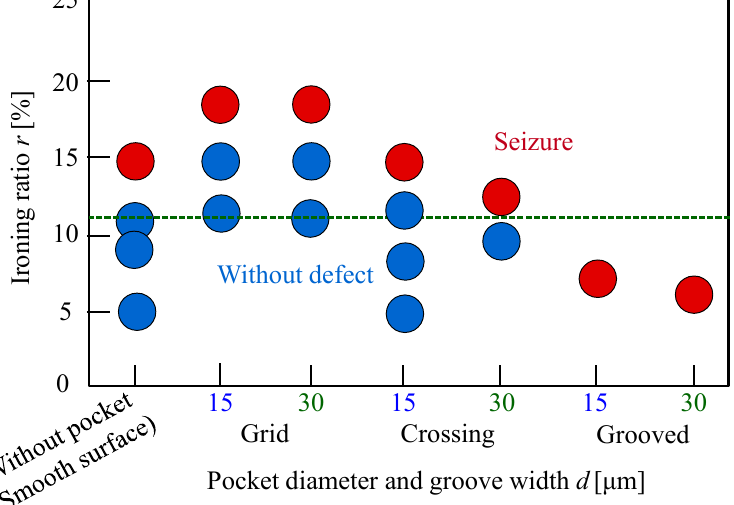
Figure 15. Ironing limit of die having lubricant pockets with different array patterns, h = 2 µ m and L = 50 µm. Table 4. Comparisons of the load-carrying force F ∗ z , the shear force F ∗ between the grid and crossing array